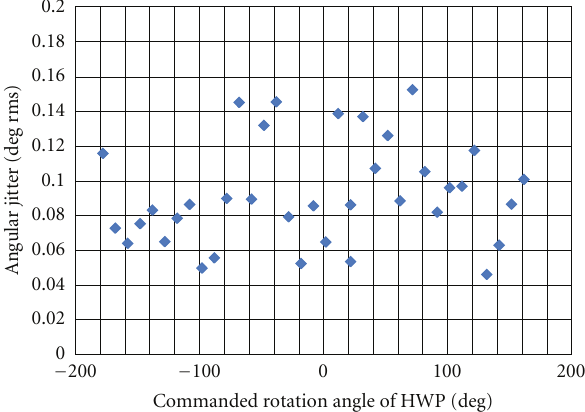
Figure 12: Photographs of field QKD experiments between two buildings in suburban Tokyo.